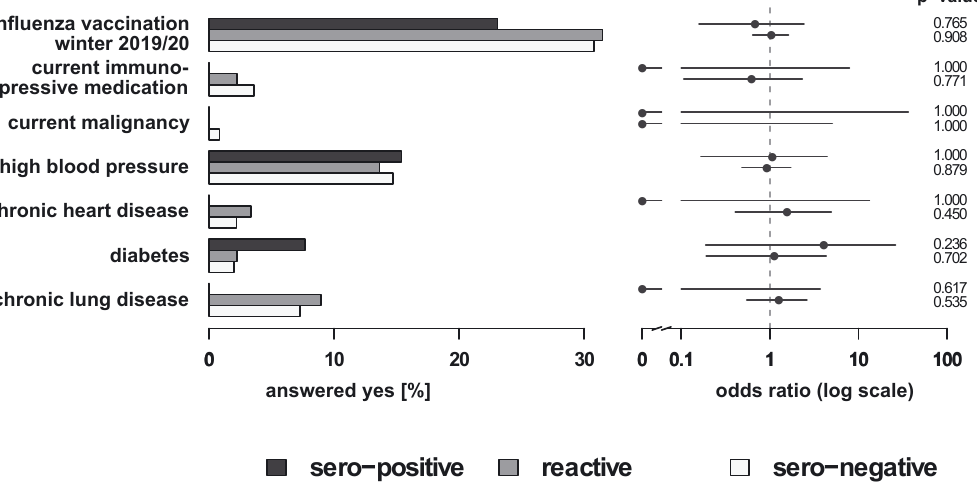
Figure 4: Comparison of preexisting disorder and medical history items in sero-positive, reactive, and sero-negative employees. The horizontal barson the left indicatethe percentage of the answer “ yes ” to the indicated itemsamong the sero-positive, reactive,and sero- negativeemployees.Thedotsontherightindicatetheestimatedoddsratiobetweenthesero-positiveandthesero-negative,andbetweenthe reactiveandsero-negativeemployees.Thehorizontallinescorrespondtotherespective95%confidenceinterval.Onthefarrightthep-values of the Fisher ’ s Exact Test are